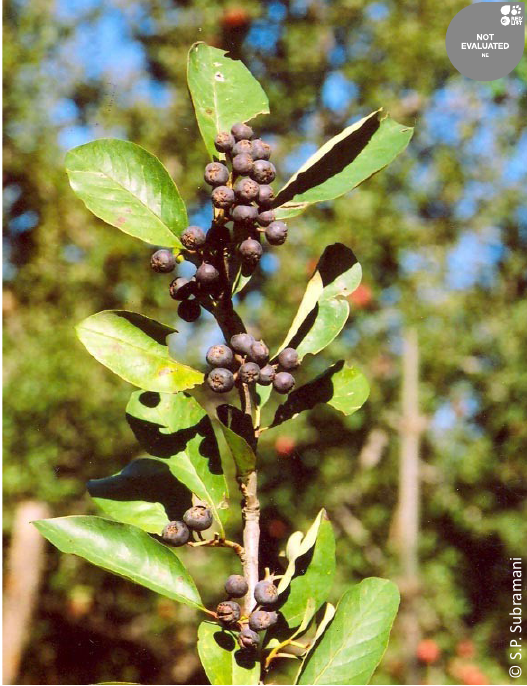
Image 39. Cotoneaster bacillaris Wall. ex Lindl.